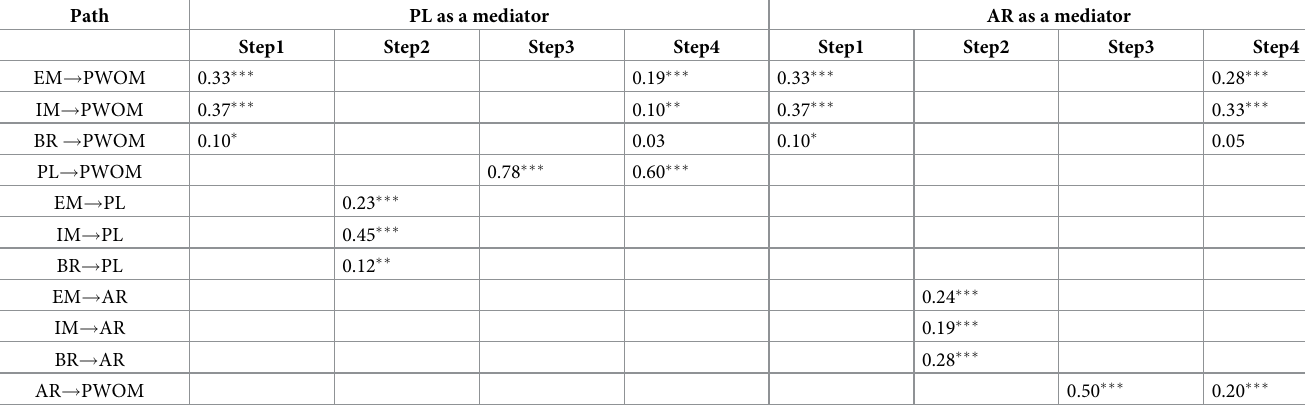
Table 4. Results of the Baron and Kenny mediation